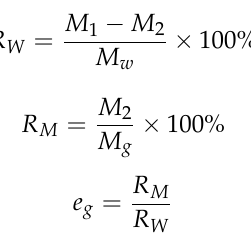
Figure 4. SEM images of the test samples: ( a , b ) graphite; ( c , d ) mica; and ( e , f )